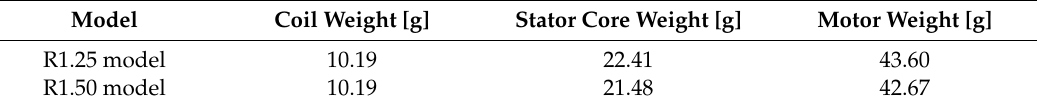
Table 3. Weight of coils, stator core, and motor for the R1.25 model and R1.50 model.